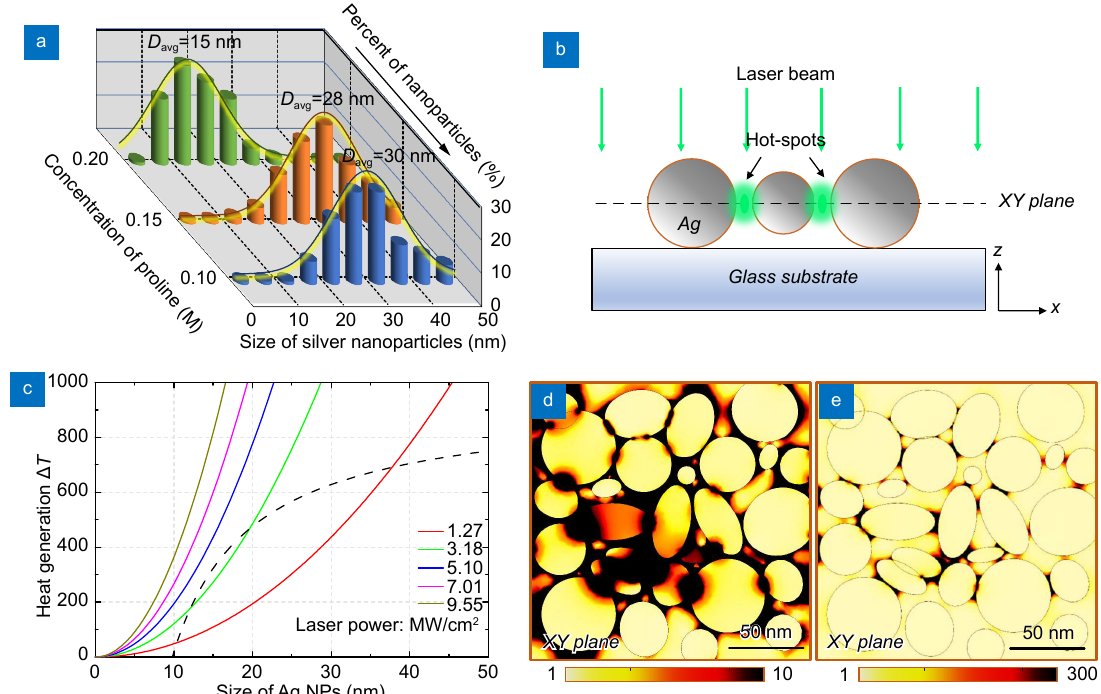
Fig. 5 | ( a ) Size distribution of Ag NPs in the Ag NWs fabricated in the silver ion contained precursor solutions at different concentrations of sur- factant. ( b ) Schematic of simulation setup, a planar configuration is taken as an example. ( c ) Calculated temperature increasing Δ T (°C) at the surface of Ag NPs as a function of Ag NPs size, considering the local light intensity increased 300 times. The black areas (hot-spots) present the simulation results of the temperature distributions when the enhanced light field intensity increases 10 ( d ) and 300 ( e ) times by using FEM meth-